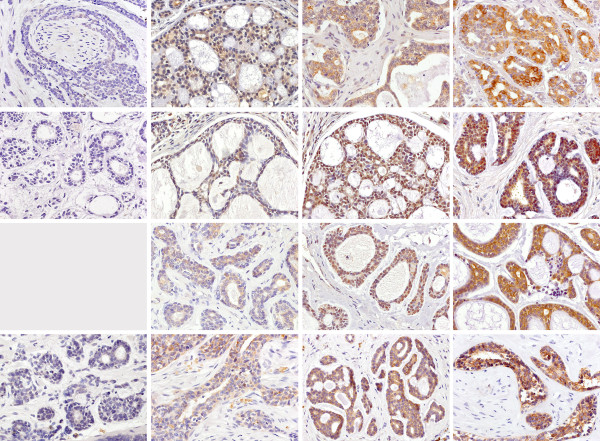
Examples for immunohistochemical staining results: row 1: p-AKT, row 2: TKTL-1, row 3: M2PK, row 4: GLUT-1; column 1: negative (no negative case was found when M2PK was stained), column 2: weak, column 3: moderate, column 4: strong.